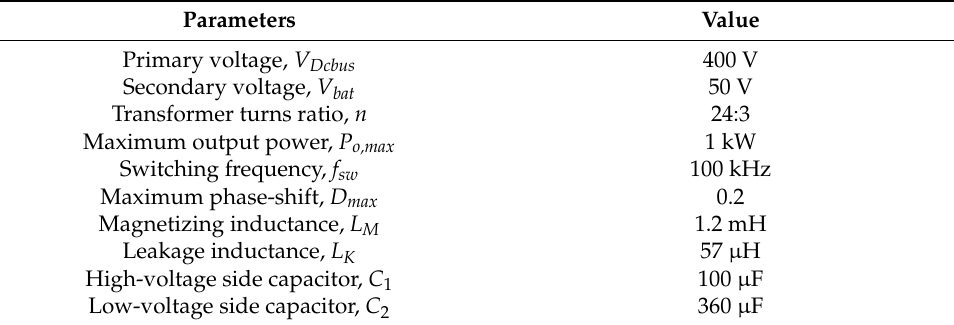
Table 3. Specifications of the proposed DAB converter prototype.